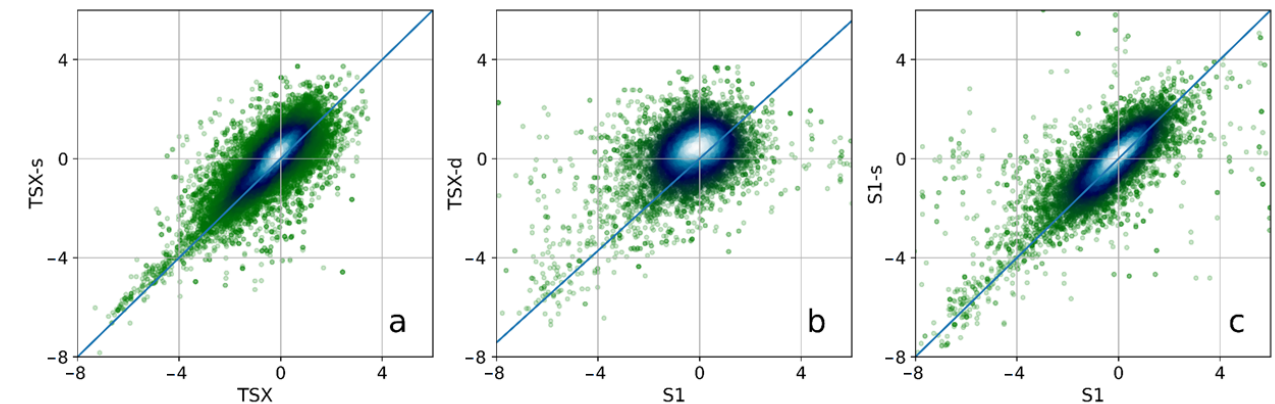
Figure 9. Scatter plot comparing displacement rates from the different satellites at the common pixels: ( a ) TSX-s deformation versus TSX deformation; ( b ) TSX-d deformation versus S1 deformation; ( c ) S1-s deformation versus S1 deformation. All of the deformations are in LOS directions. Rates are in mm/y. The line is the LOS ratio line, which was calculated using the look angles of the datasets. The R-squared values for the three plots ( a – c ) were 0.50, 0.06, and 0.39, respectively; the respective biases for each were 0.53, 1.00, and 0.69.